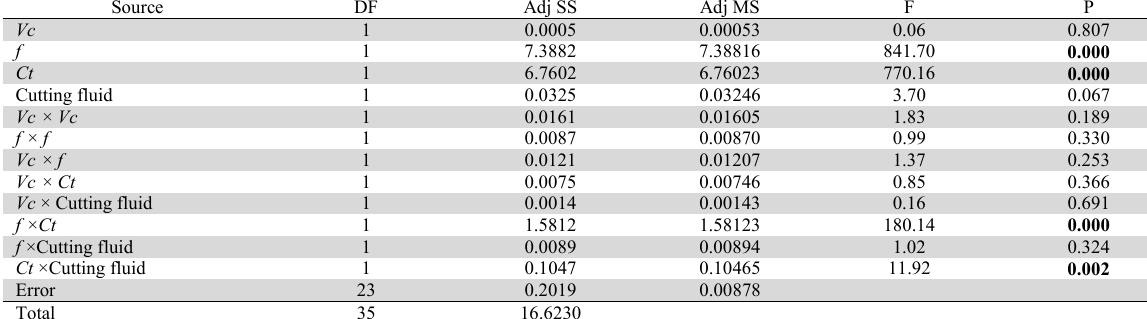
Response surface design for Surface Roughness (Ra) Source DF Adj